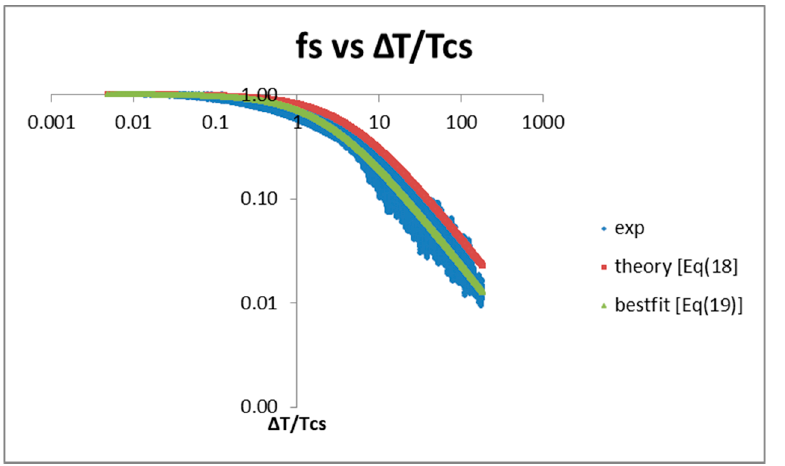
Figure 1. The concentration variance ratio (cid:2026) (cid:3004)(cid:3020)(cid:2870) (cid:2026) (cid:3004)(cid:3020)(cid:2868)(cid:2870) ⁄ as a function of Δ (cid:1846)/(cid:1846) (cid:1829)(cid:1845) compared with ana- lytic functions (cid:1858) (cid:3020) ( Δ (cid:2002) (cid:2002) (cid:3004)(cid:3020) ⁄ ) .